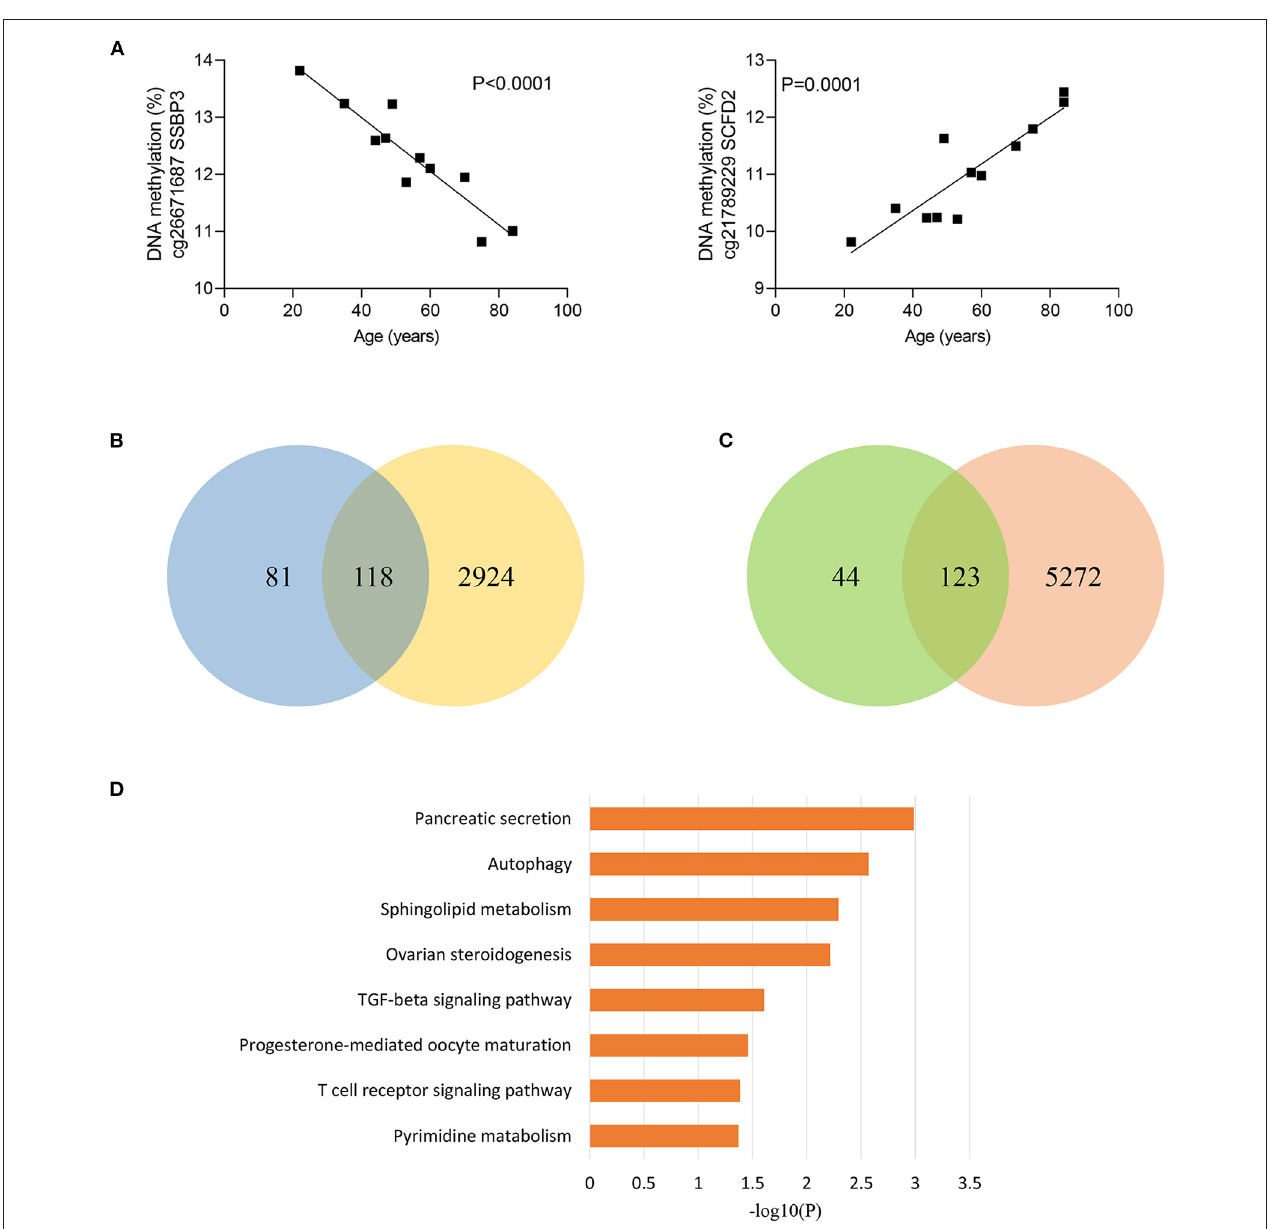
FIGURE 2 | Age-related methylation changes in controls. (A) Correlation between age and methylation of two CpG sites with the most significant correlations with age in controls as analyzed by linear regression analysis ( n = 12). (B) Venn diagram showing the intersection of the sets of hypermethylated sites with increasing age in controls and hypermethylated sites in sepsis. (C) Venn diagram showing the intersection of the sets of hypomethylated sites with increasing age in controls and hypomethylated sites in sepsis. (D) Kyoto Encyclopedia of Genes and Genomes (KEGG) pathway enrichment analysis of 227 genes distributed by 241 age-related CpG